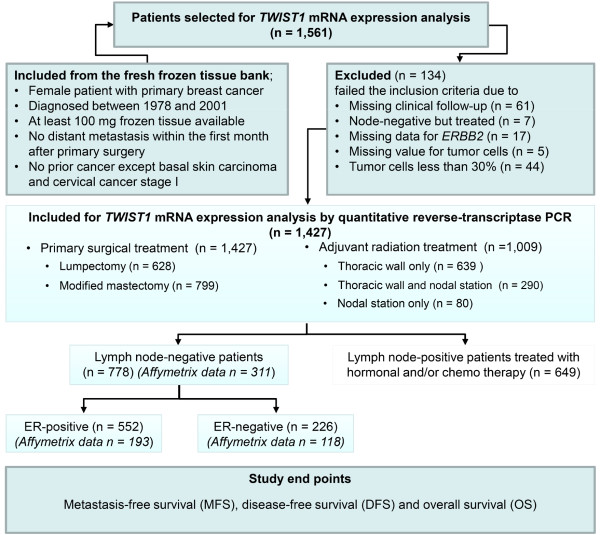
Study design, patient inclusion criteria and patient sub-cohorts analyzed. Associations of TWIST1 mRNA expression levels with tumor aggressiveness were evaluated in all patients and in LNN, LNN/ER-positive and LNN/ER-negative patients. The LNN patients in this study did not receive adjuvant systemic therapy.